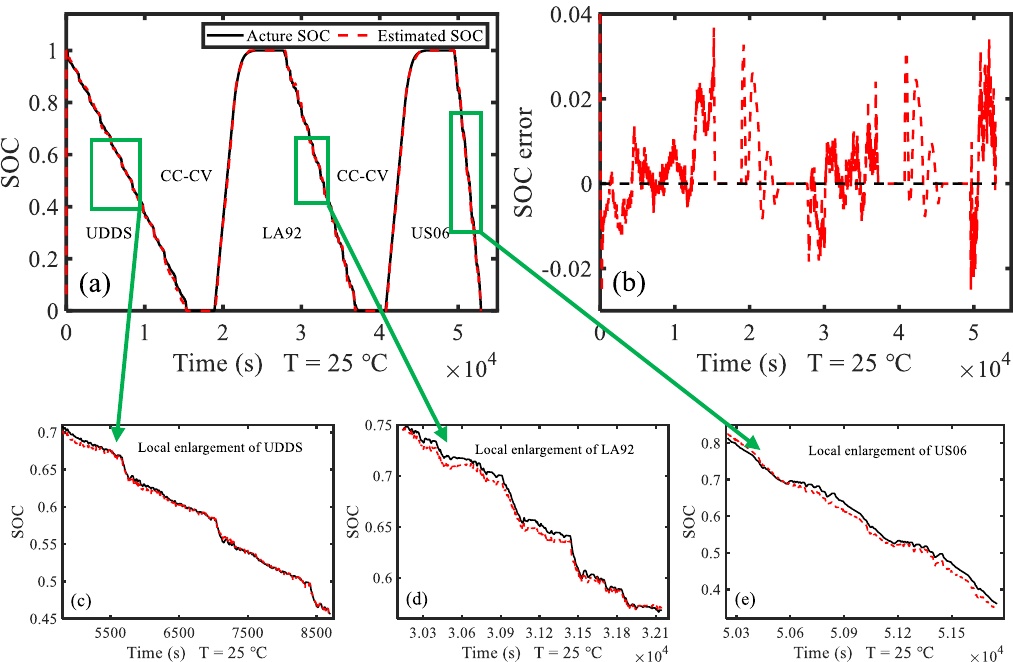
Figure 7. SOC estimation error of case 1 at 25 °C: ( a ) SOC, ( b ) SOC error, ( c ) local enlargement of UDDS, ( d ) local enlargement of LA92, ( e ) local enlargement of US06. Table 5. SOC error results of case 1 ( N GRU = 55, N FC = 160).